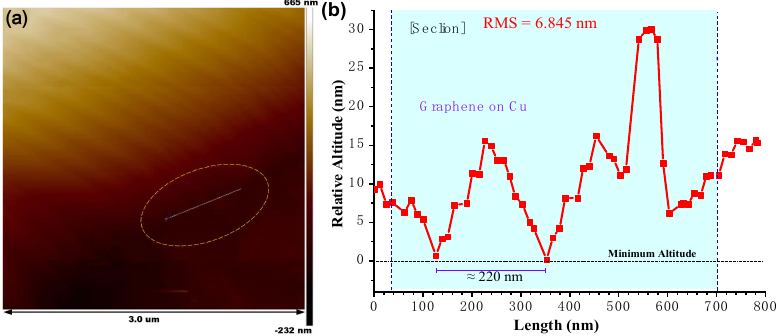
Figure 3. ( a ) AFM image of the copper foil with graphene and ( b ) the cross-section profiles along the selected white line. The lowest valley point in ( b ) is set to be 0 nm for the sake of convenience.